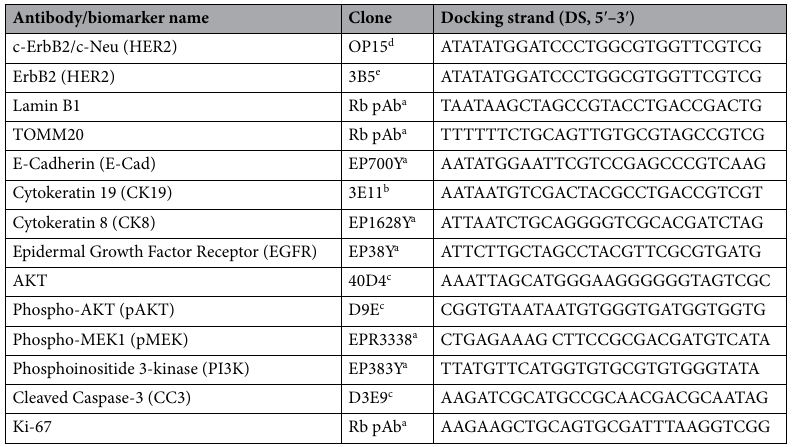
Table 2. Antibody and oligonucleotide details. a AbCam, Cambridge, MA. b Biolegend, San Diego, CA. c Cell Signaling Technology, Danvers, MA. d MilliporeSigma, St. Louis, MO. e ThermoFisher Scientific, Waltham,